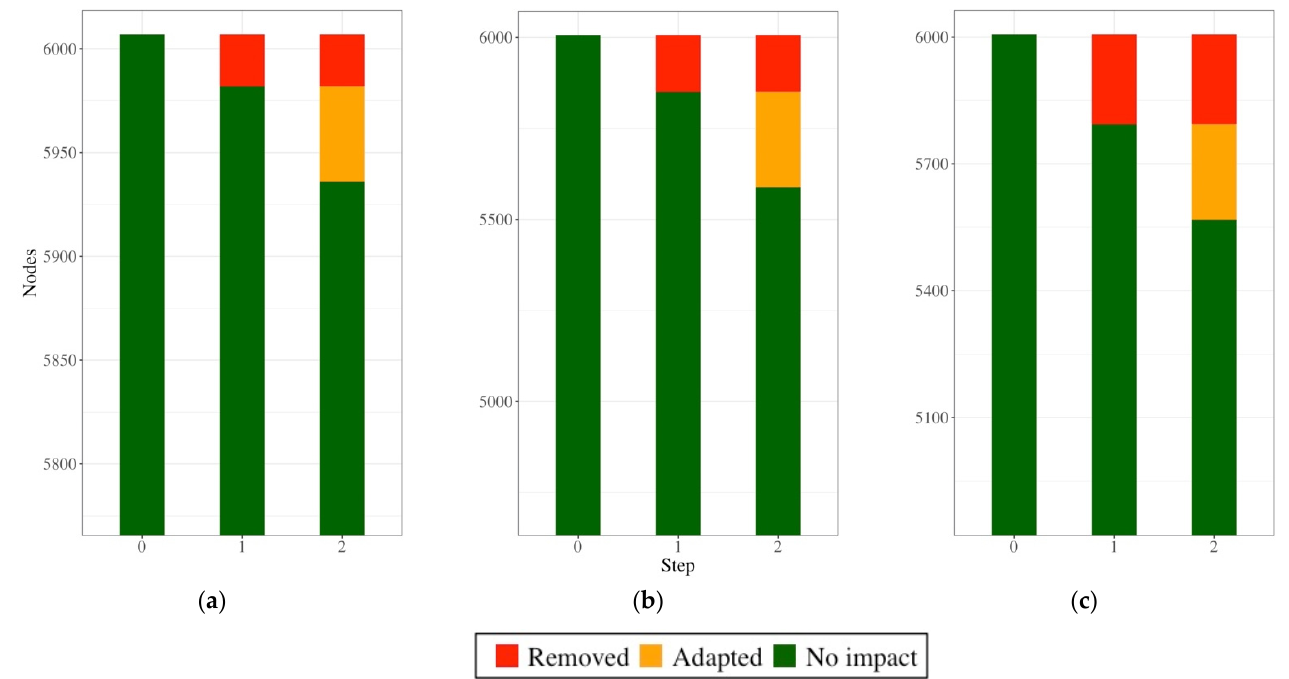
Figure 9. Impact propagations for different return periods: ( a ) fluvial scenarios and ( b ) pluvial scenarios.